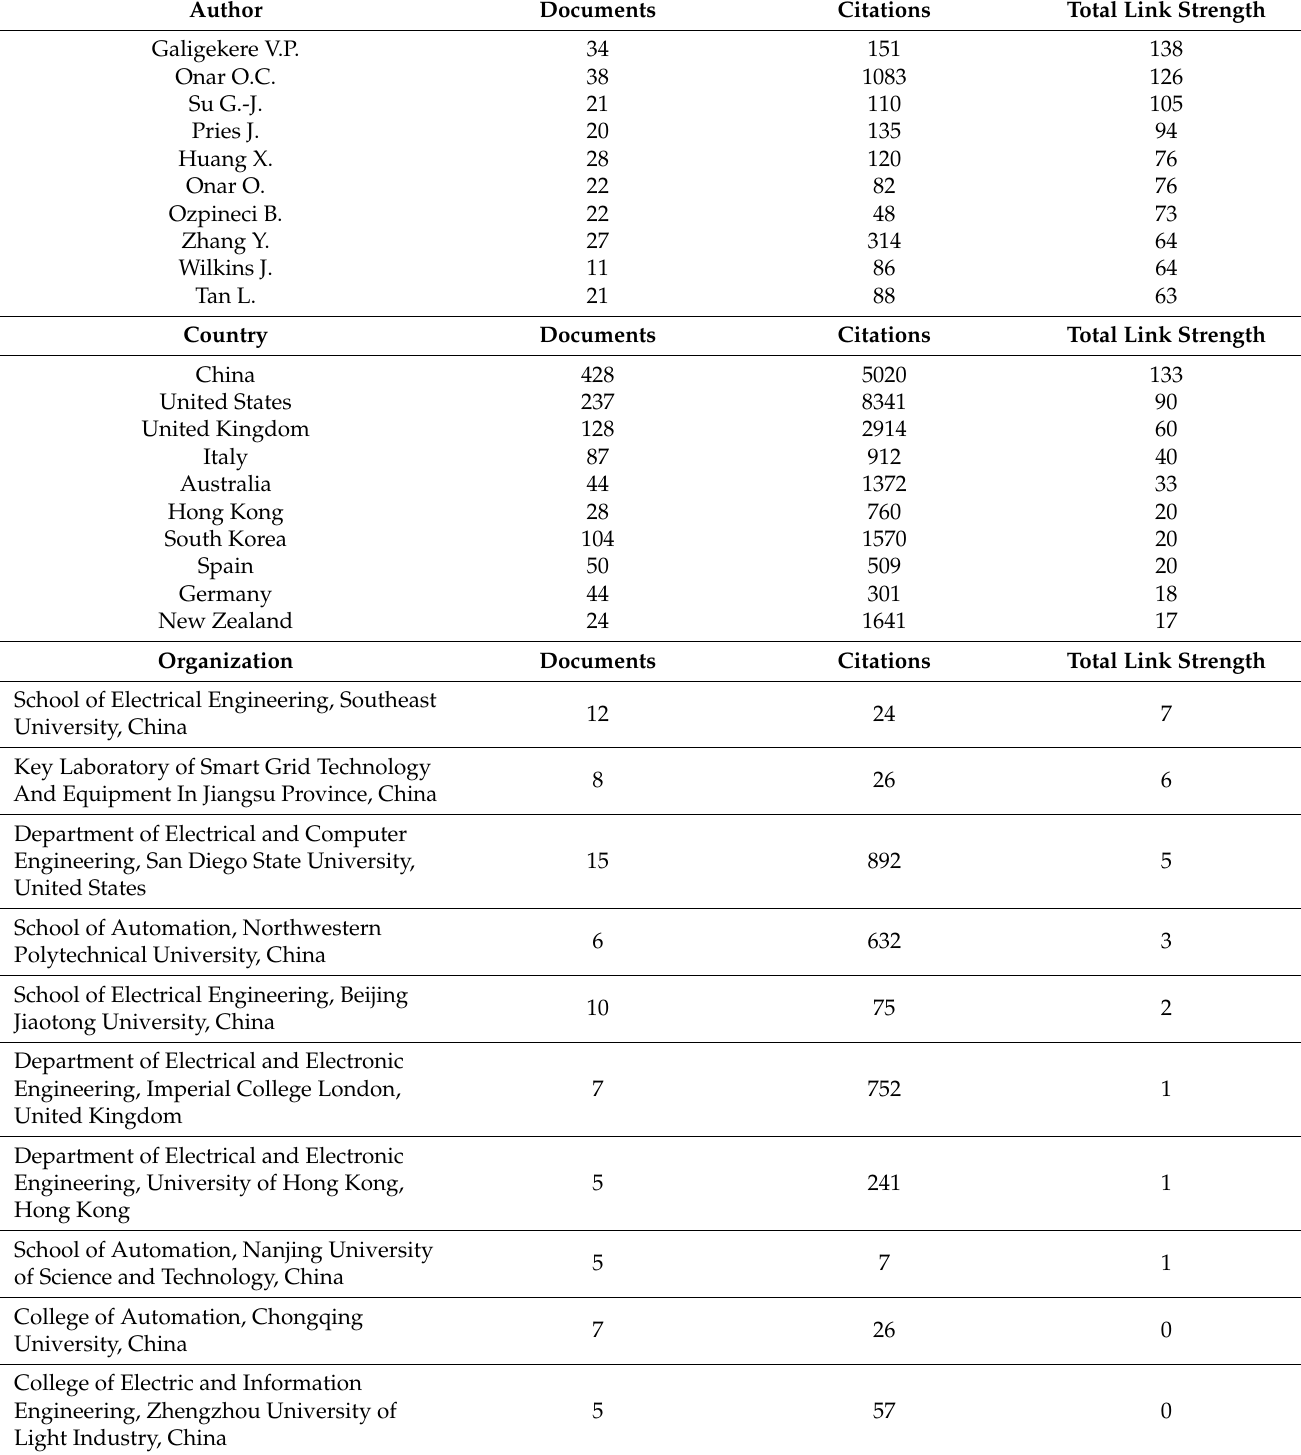
Table 2. List of Co-authorships with Author, Country and Organization as Measures for Top 10 Items Sorted According to Highest Link Strength